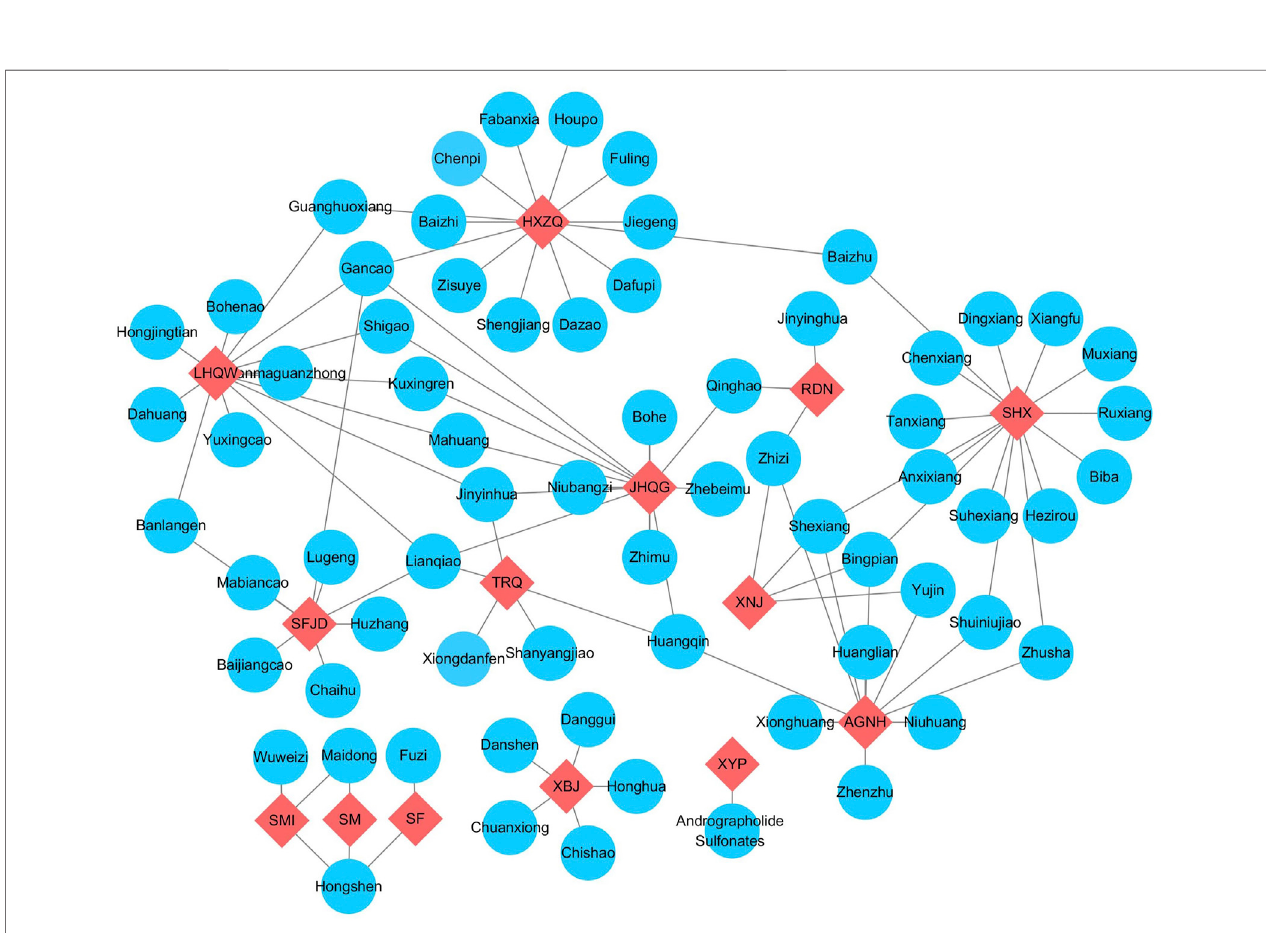
FIGURE 2 | The relationship of recommended CPMs and compositions. Note: The red nodes represented different CPMs, and compositions were labelling blue. AGNH, angong Niuhuang Pill; HXZQ, huoxiangzhengqi capsule; JHQG, jinhuaqinggan granules; LHQW, lianhuaqingwen capsule; RDN, reduning injection; SF, shenfu injection; SFJD, shufengjiedu capsule; SHX, suhexiang pill; SM, shenmai injection; SMI, shengmai injection; TRQ, tanreqing injection; XBJ, xuebijing injection; XNJ, xingnaojing injection; XYP, xiyanping injection.